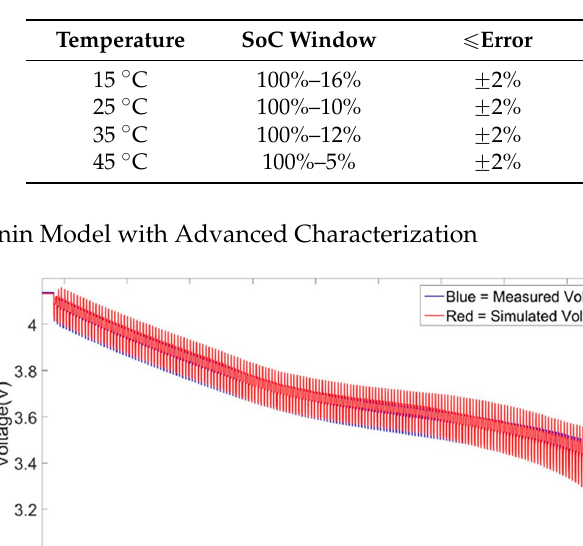
Figure 13. 1st order Thévenin model measured and simulated DDP comparison at 25 °C with Coulomb counting and advanced characterization.